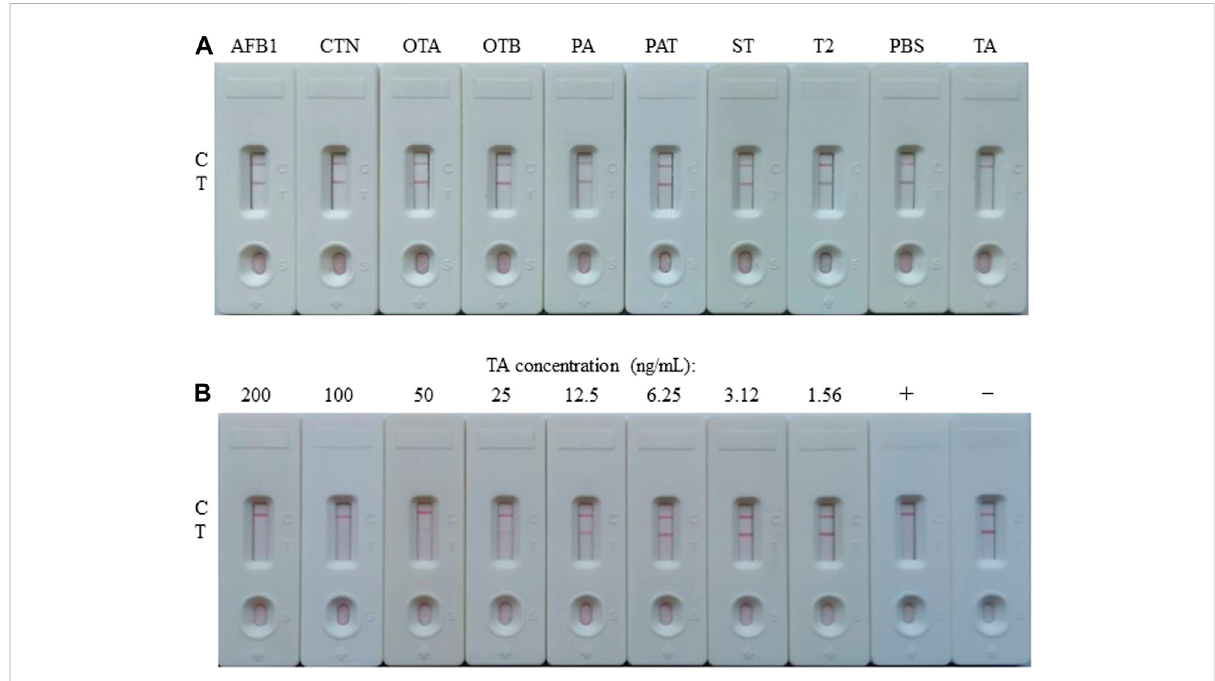
FIGURE 3 Preparation and characterization of the AuNP-based LFIA. (A) Speci fi city of the AuNP-based strip test with other toxins, such as a fl atoxin B1 (AFB1), citrinin(CTN), ochratoxin A(OTA),ochratoxinB(OTB), penicillicacid (PA), patulin (PAT),sterigmatocystin (ST),ortrichothecenes-2(T2), while PBS as negative. (B) The sensitivity of the AuNP-based strip test. +: positive, ‑ :